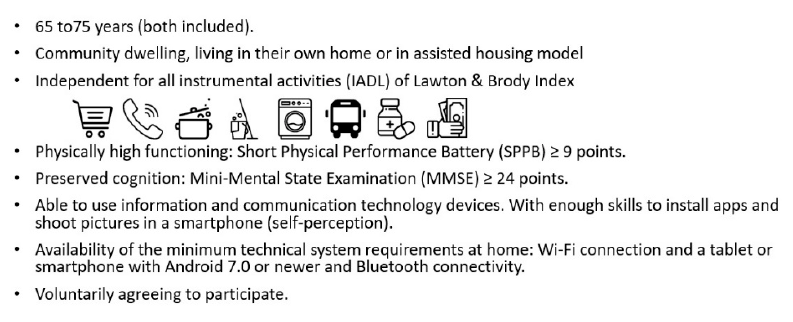
Figure 10. Eligibility